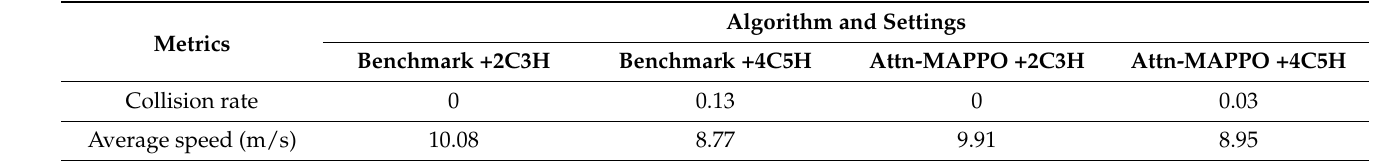
Table 1. Performance comparison between the benchmark and the proposed Attn-MAPPO (proposed) algorithm.